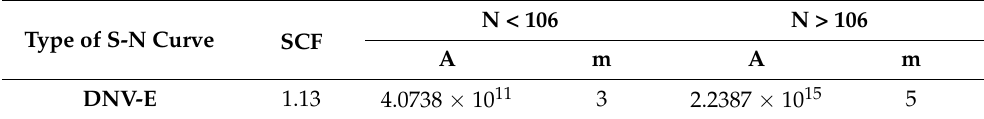
Table 3. Details of the DNV-E curve.